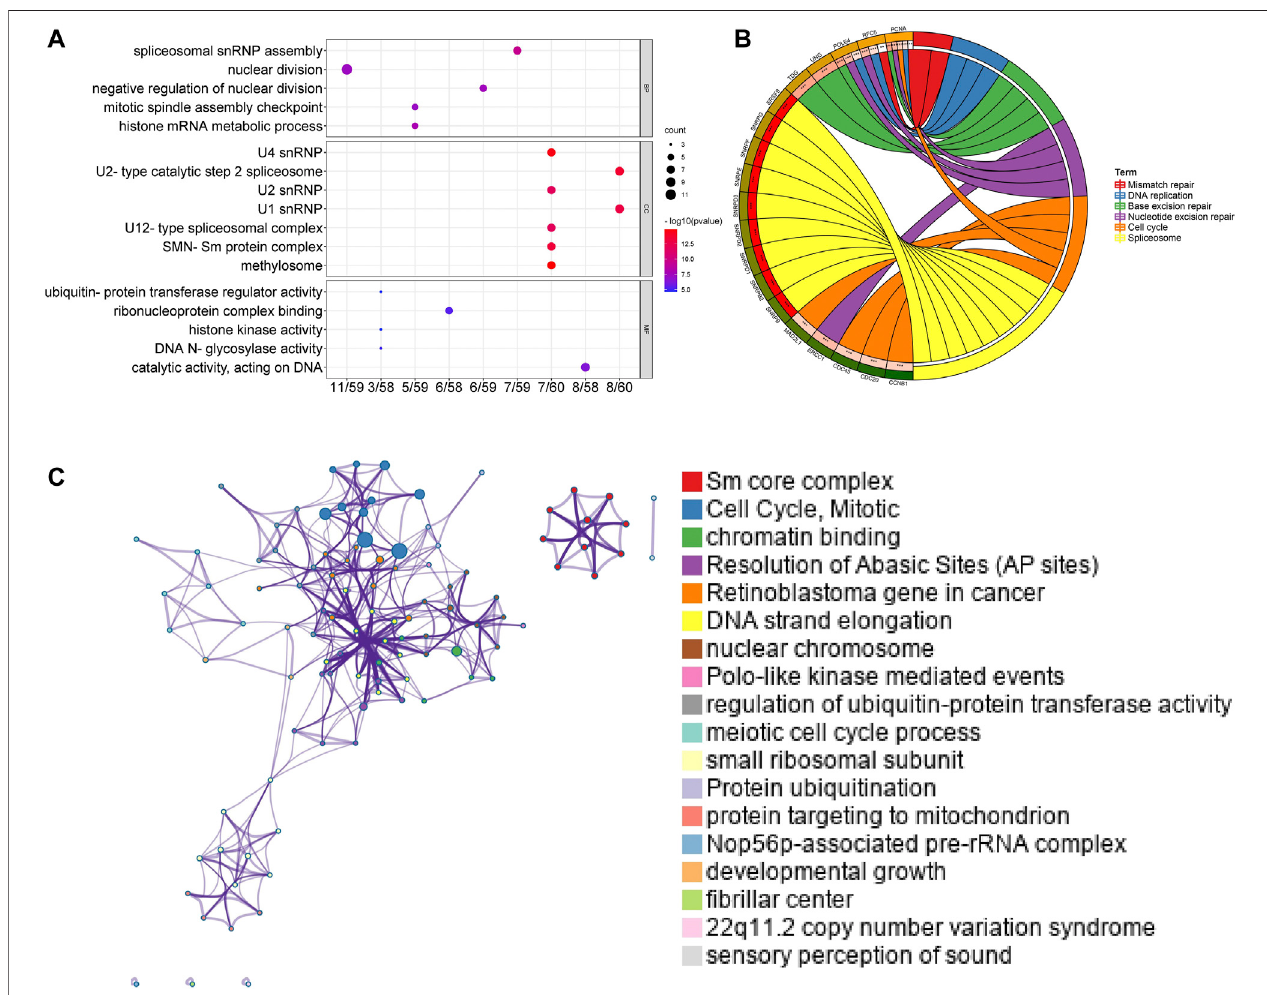
FIGURE 7 | Functional and enrichment analysis for Sm proteins genes and their 50 neighboring genes in LUAD (DAVID 6.8, Metascape). (A) GO enrichment analysis of genes for Sm proteins and their 50 neighboring genes (DAVID 6.8). (B) Chord diagram of KEGG analyses results. (C) Network of seven enriched terms, colored by cluster ID